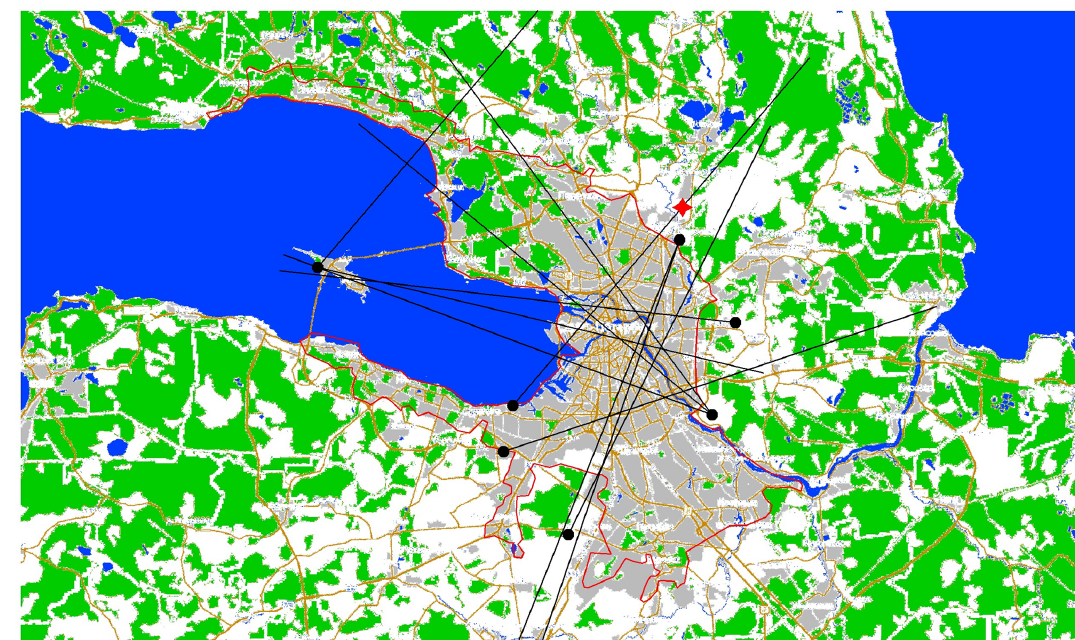
Figure 6. An example of linear backward paths (black straight lines; black dots show the downwind FTS locations) for the days of FTIR observations. The major land use classes are shown by different colours (blue for the water bodies, grey for the residential buildings/industrial areas and green for the parks and forests). The path lengths on the map are plotted as equal only for illustrative purposes. In fact they are all different since the FTIR observation locations and the wind field change from day to day. The red line designates the official administrative boundary of the St. Petersburg agglomeration. The red star indicates the location of a the major thermal power station (TPS) located to the north of St. Petersburg. Map data © 2019